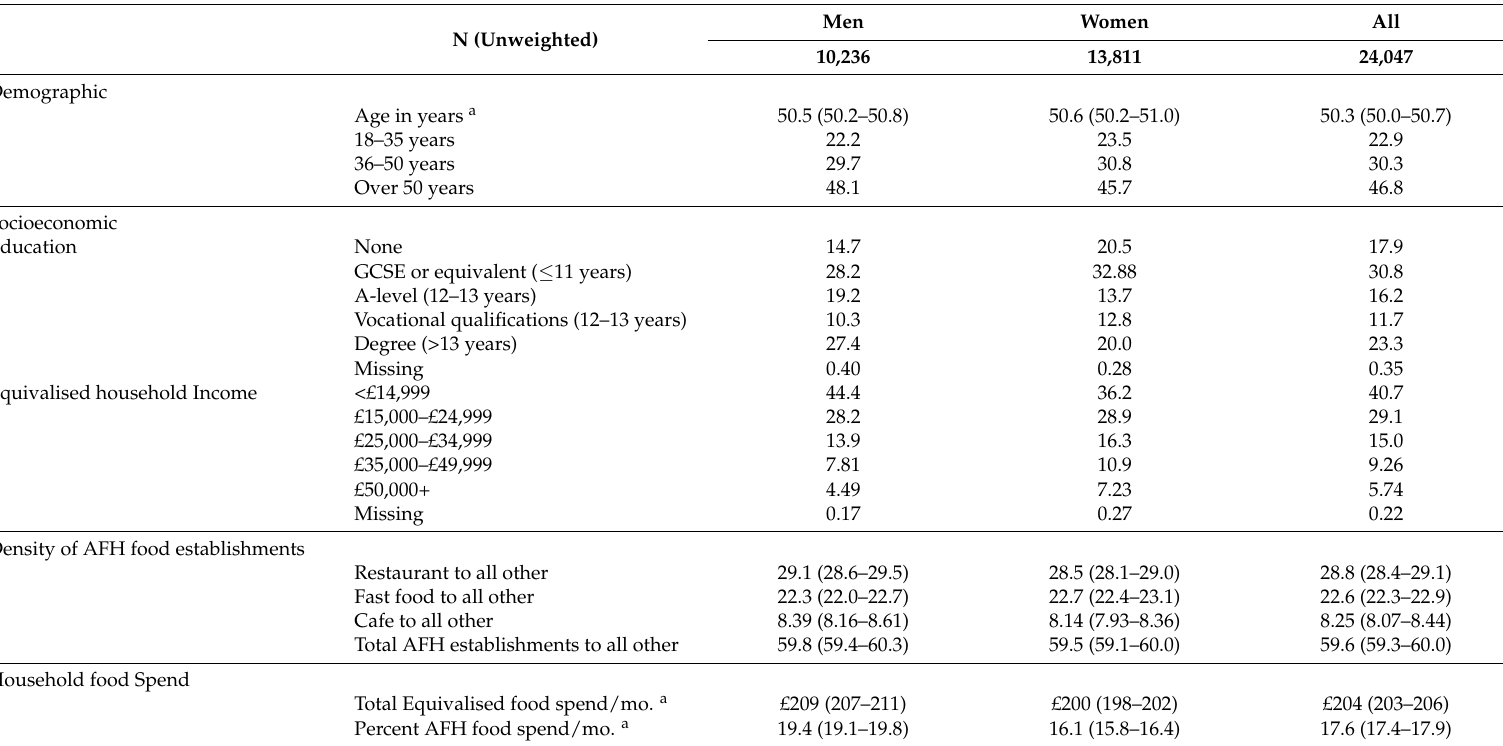
Table 1. Weighted sample characteristics for analytical sample ( n = 24,047) from Wave 1 as percentage or mean and 95% CI where